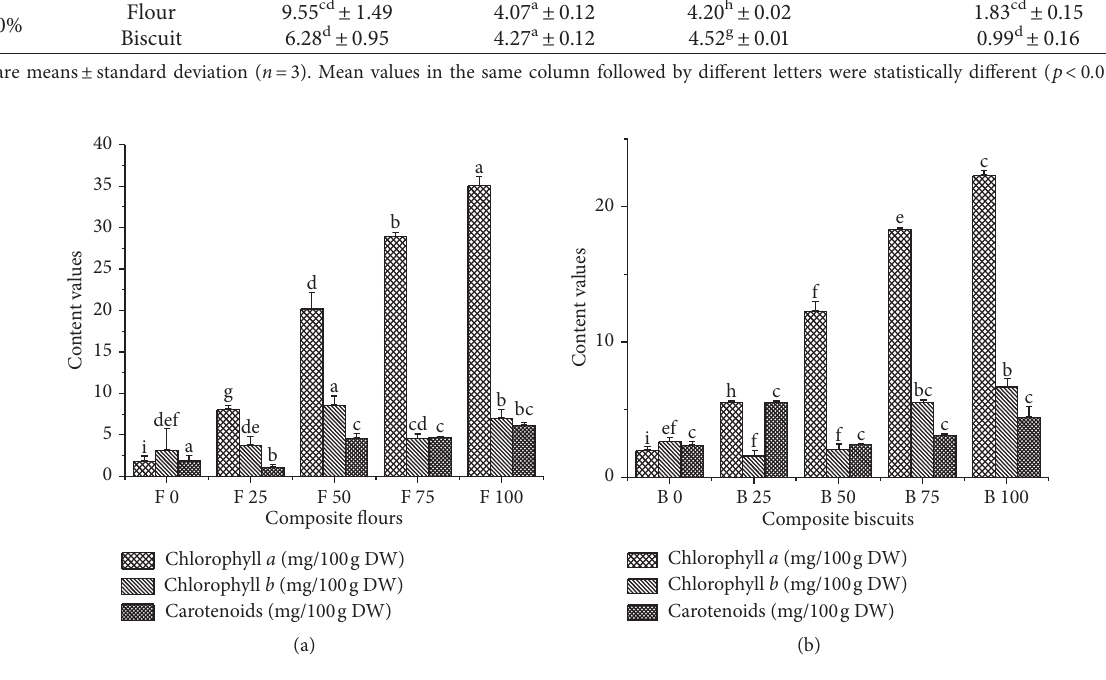
Figure 2: Chlorophyll a and b and carotenoids of flour and biscuit samples. Values indicated by different lowercase letters are significantly different ( p < 0 . 05) according to Tukey’s test.